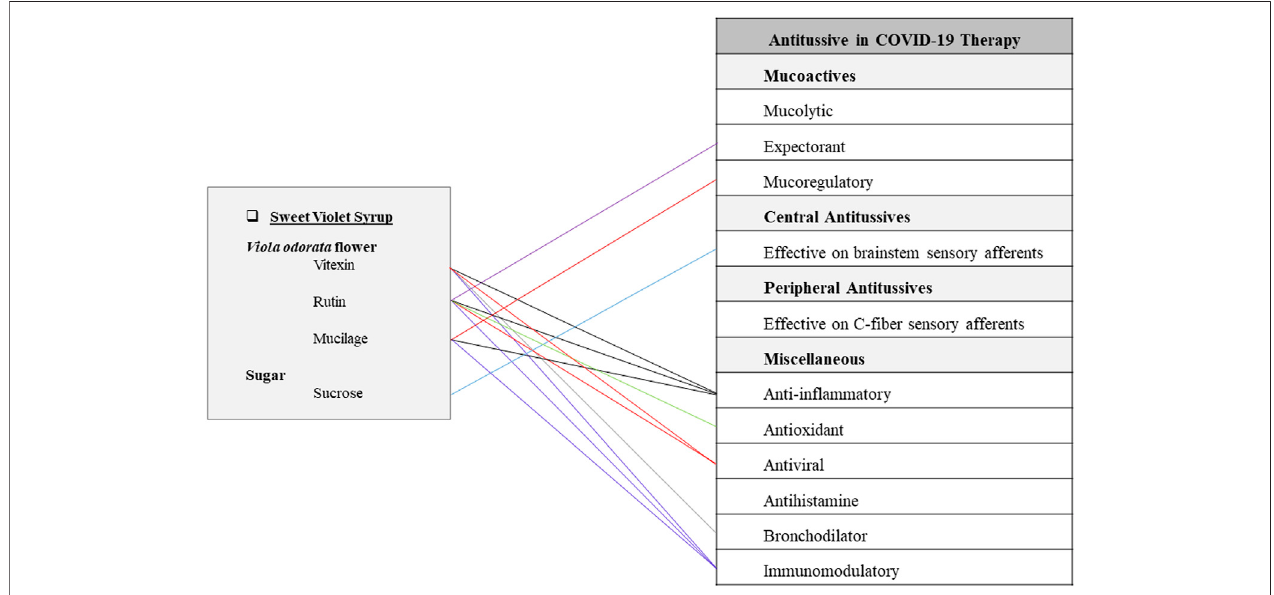
FIGURE 5 | Potentials of sweet violet syrup as an antitussive Persian functional food in COVID-19 therapy.